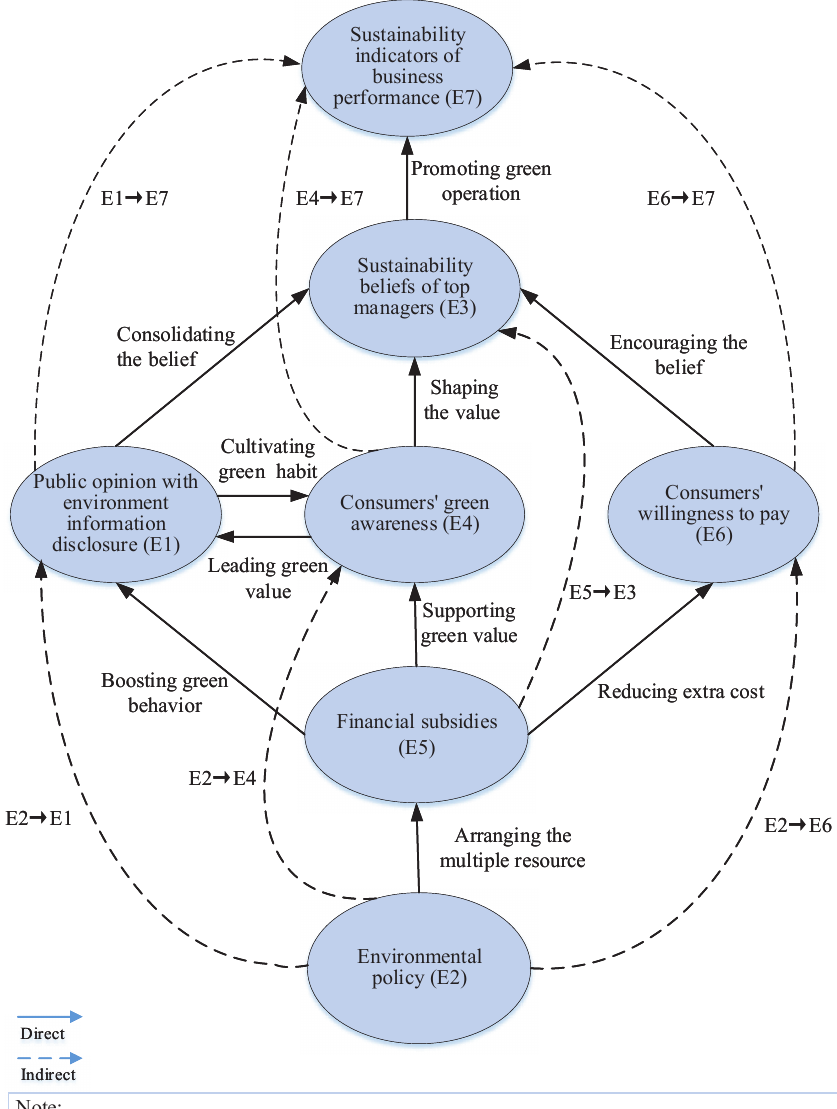
Figure 3. The diffusion network of the enablers of